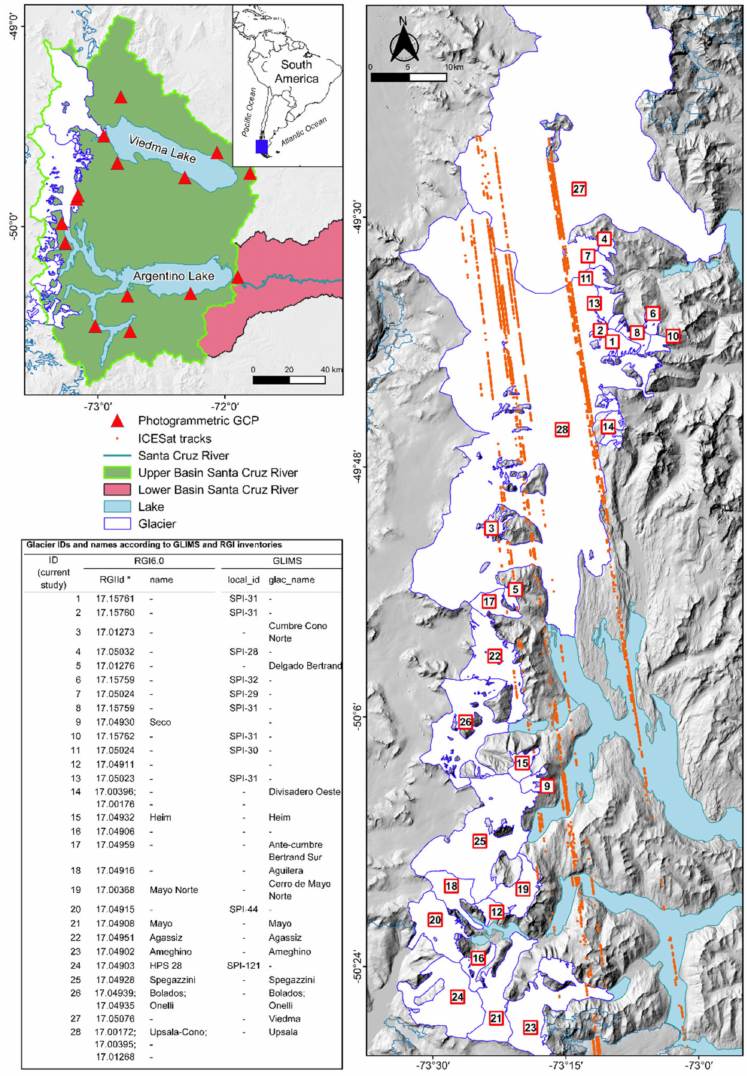
Figure 1. Study area and ground control points (GCP) distribution. The glacier outlines presented here correspond to the glacier limits in 1979 according to Hexagon images. The hillshades on which the glacier outlines are mapped were made from the ALOS Global Digital Surface Model (AW3D30, https://www.eorc.jaxa.jp/ALOS/en/aw3d30/data/index.htm (accessed on 12 July 2020)). * All the IDs from RGI6.0 inventory start with the prefix “RGI60-”, which has been omitted for space